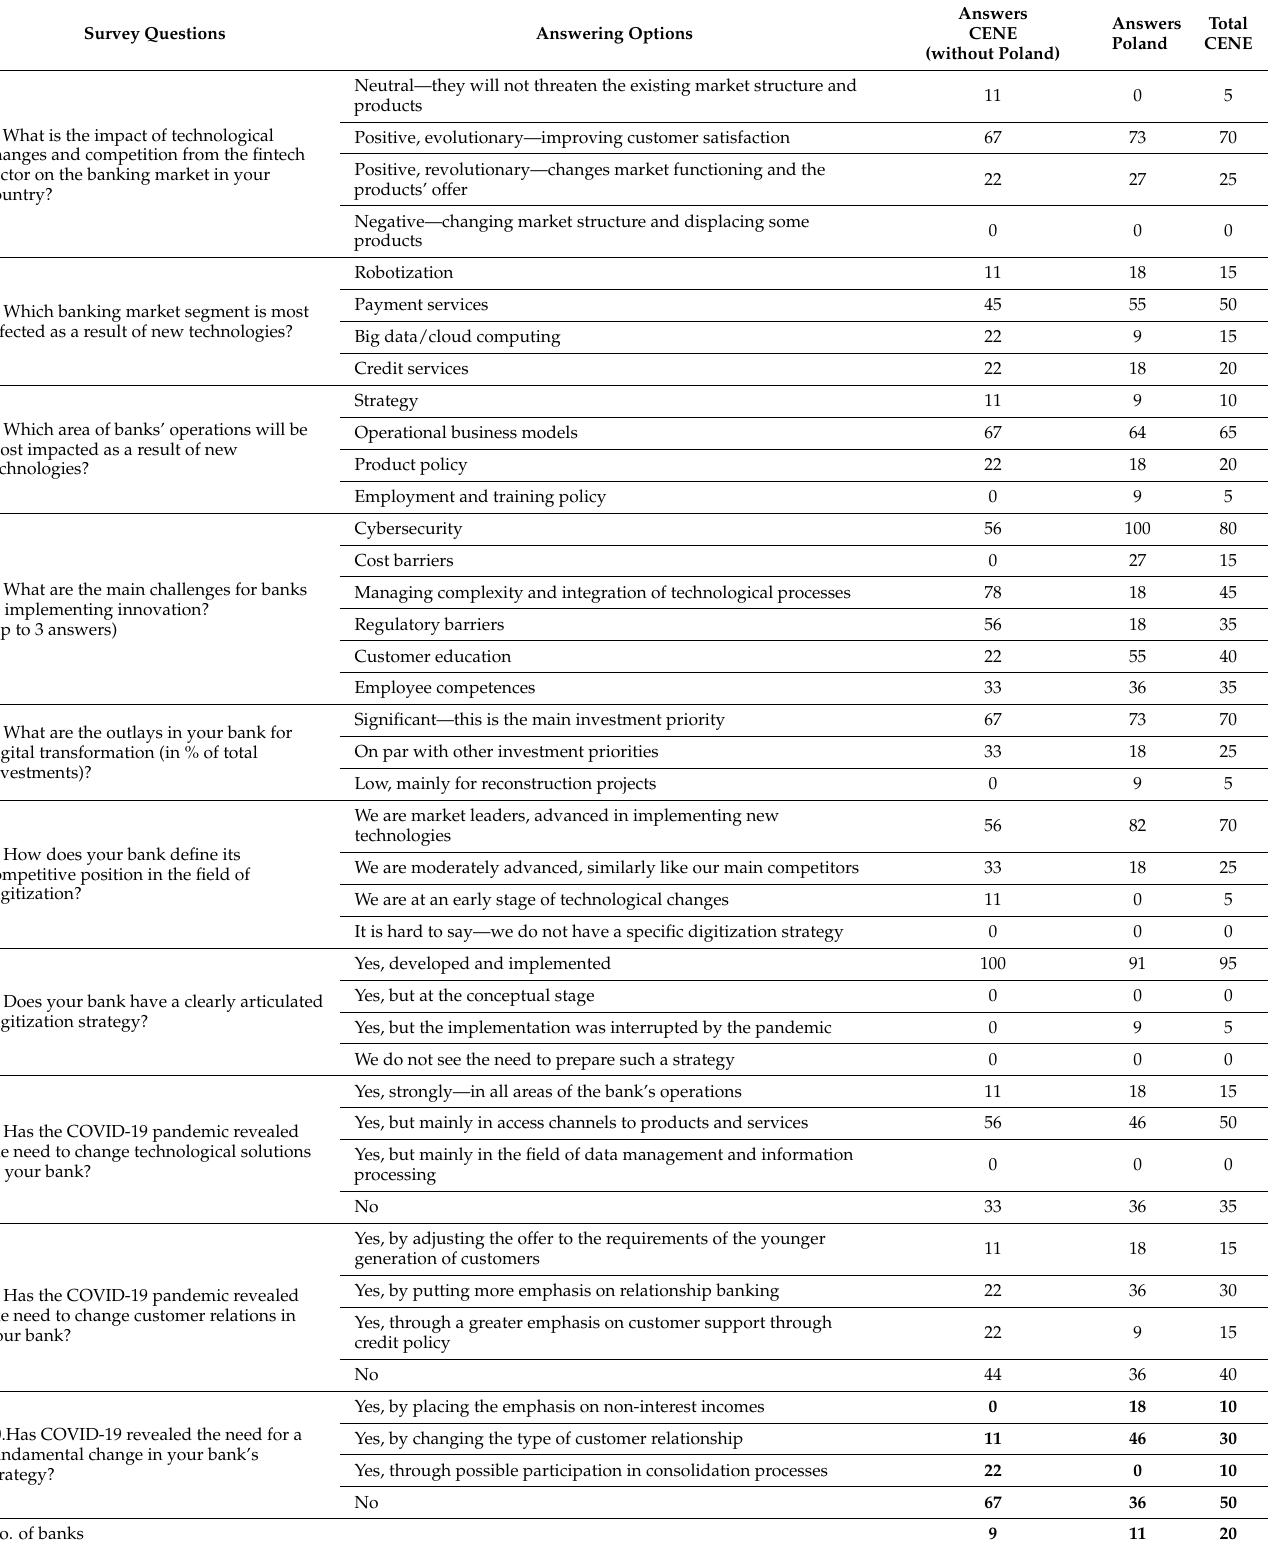
Table A1. Digitalization challenges: CENE bank survey, 2021